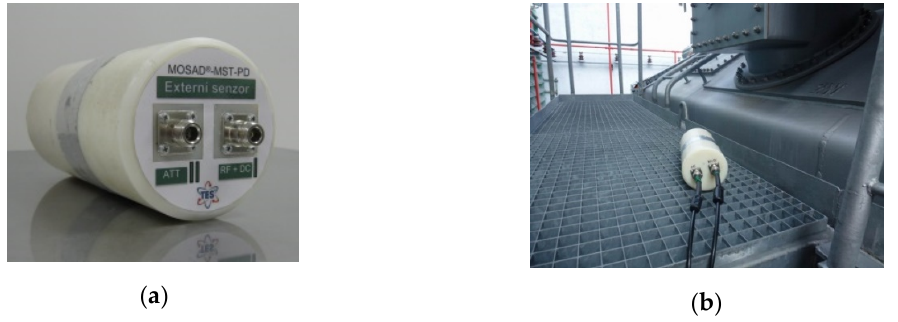
Figure 17. The external sensor for detecting outer EM impulse disturbance ( a ) and its placement on a service footbridge on the top of the transformer during a diagnostic ( b